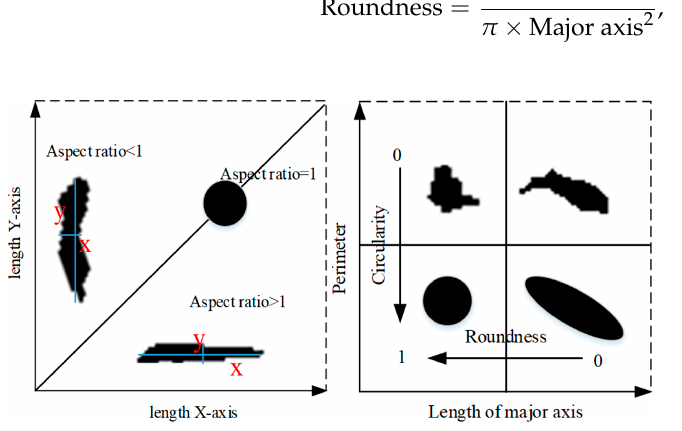
Figure 5. Shape features.